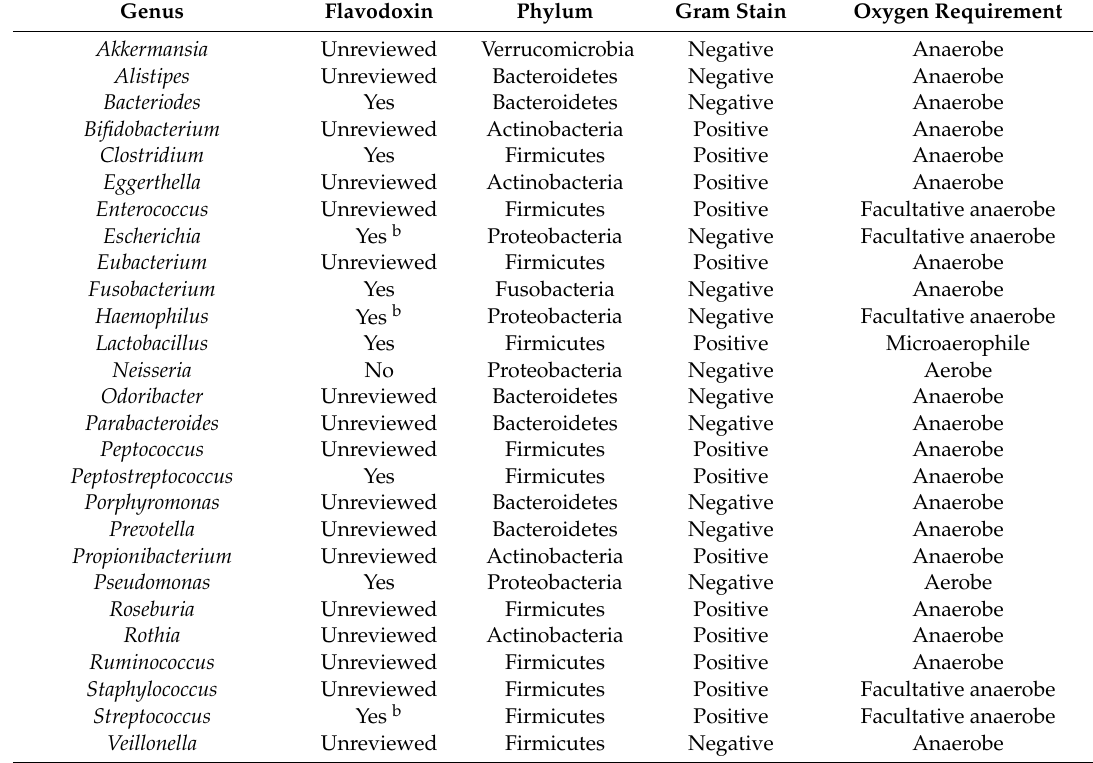
Table 4. Flavodoxin in the main bacterial genera of the human gut microbiota a .